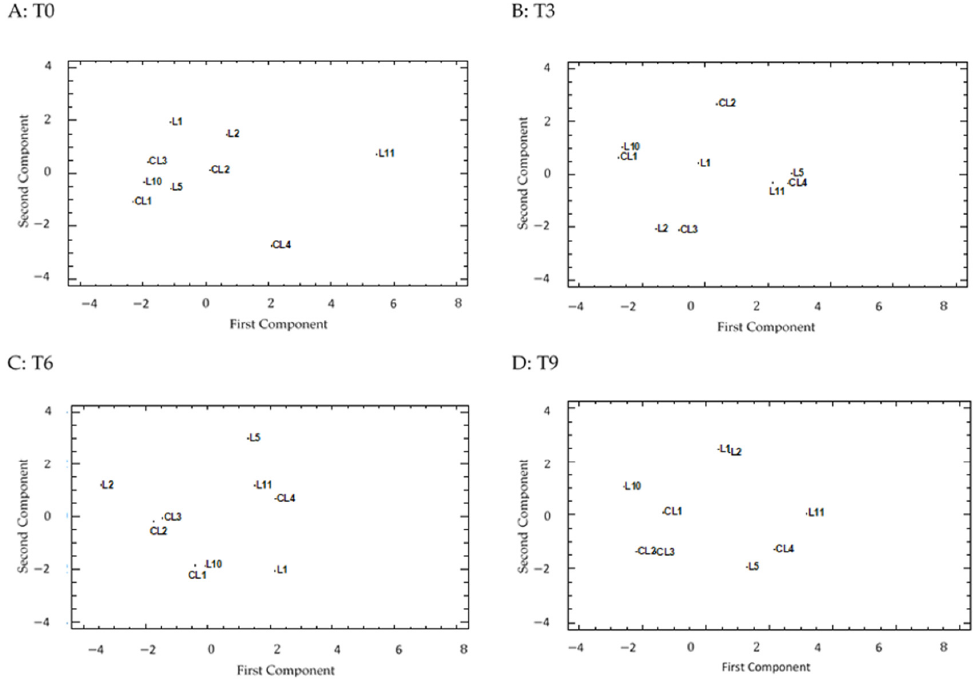
Figure 5. The principal component analysis (PCA) of the nine lettuce varieties based on the quality traits represented in the two first components (PC 1, X -axis; PC 2, Y -axis) of the PCA for (A) 0 days (T0) (56.46% and 17.89% of total variation, respectively), (B) 3 days (T3) (42.11% and 19.85% of total variation, respectively), (C) 6 days (T6) (34.66% and 26.47% of total variation, respectively) and (D) 9 days (T9) (37.49% and 24.89% of total variation, respectively) after conservation under chamber conditions.